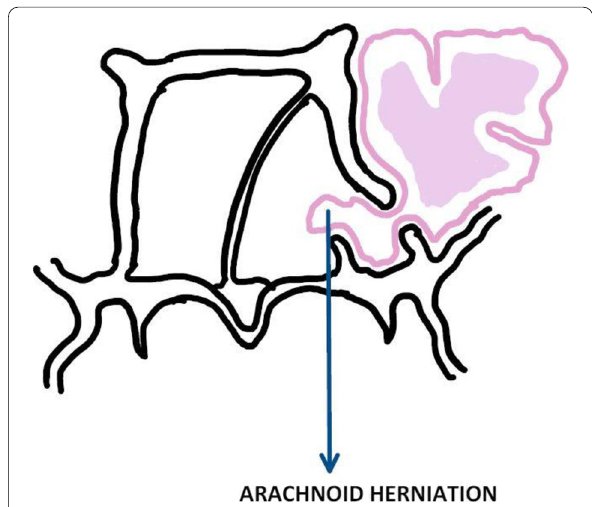
Fig. 4 Sketch of arachnoid herniation through the defect in the lateral recess of sphenoid